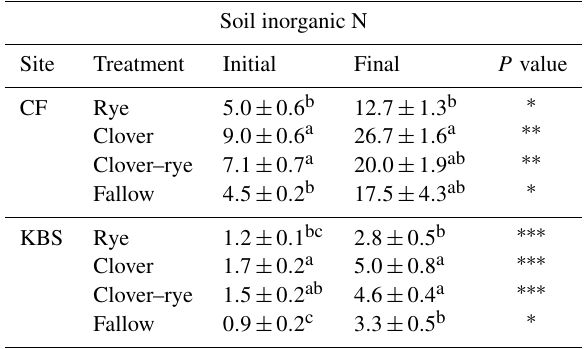
Table 2. Mean ± standard error for soil inorganic N (mgNkg − 1 soil) at initial and final sampling points separated by site and treatment. There was a significant difference between sites at both time points ( < 0 . 0001). P values are indicated as follows: ∗ < 0 . 05, ∗∗ < 0 . 01, and ∗∗∗ < 0 . 001 for differences be- tween time points for each treatment in the last column. Significant treatment differences (within each site) are indicated by different letters.